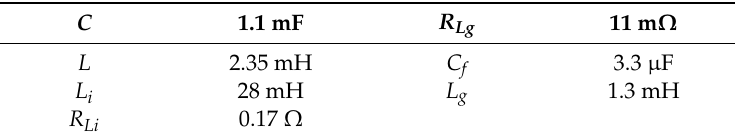
Table 1. Parameters of main passive